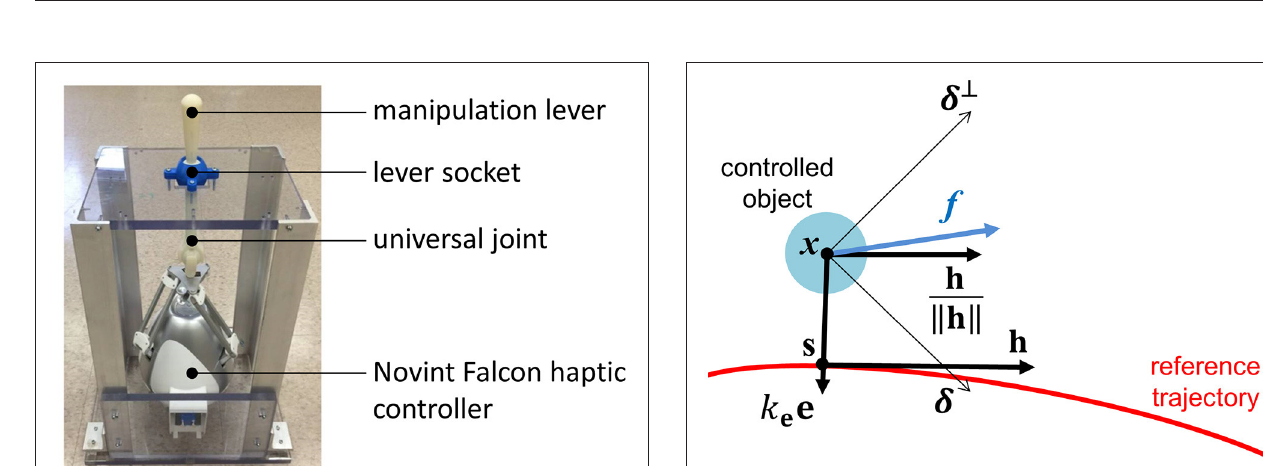
FIGURE 4 | The anatomy of the wearable skin-stretcher: Front view (A) and Rear view (B) . The entire length can be adjusted by the number of Module II with respect to the subject’s forearm thickness.